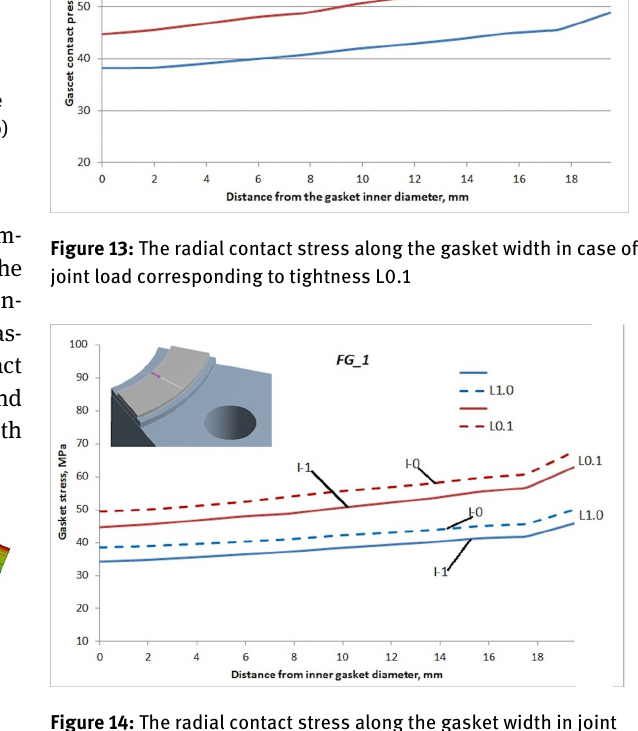
Figure 12: Contact stress distribution in operating state and flange load corresponding to tightness L0.1 a) joint gasketed with FG_1 b) joint gasketed FG_2